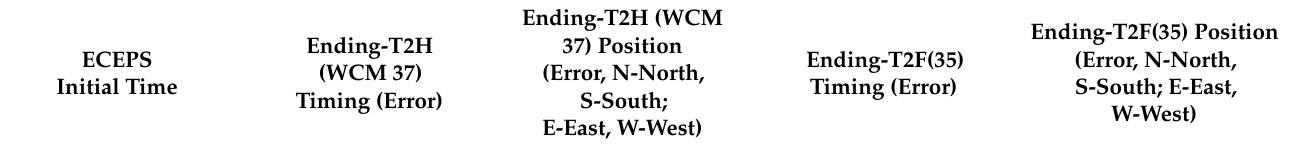
Table 3. ECEPS Timing and Position Predictions of T2F(35) and T2H during